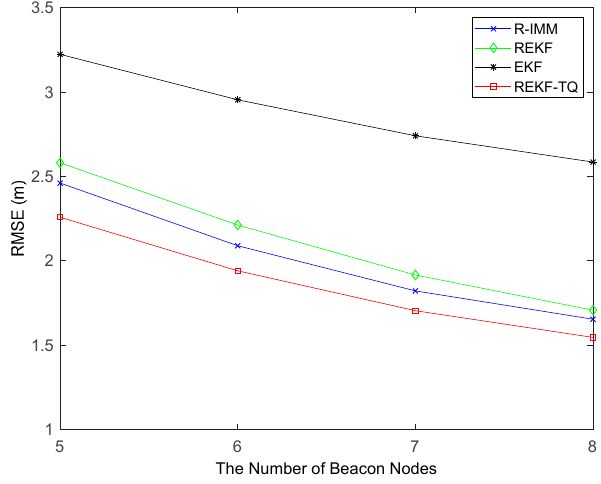
Figure 10. The RMSE versus the number of beacon nodes.